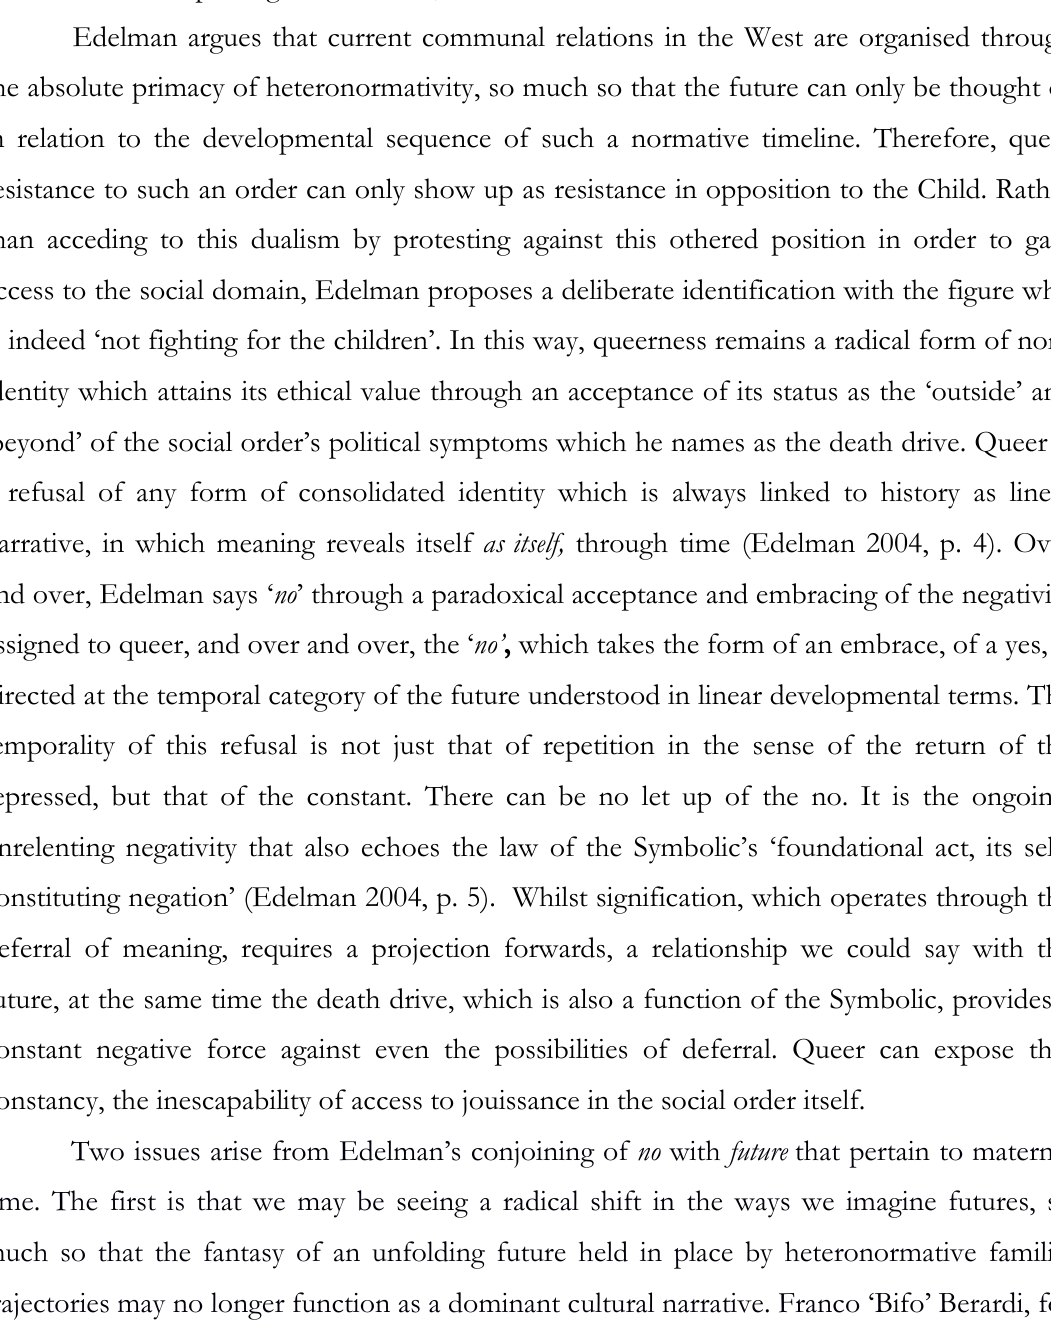
Lisa Baraitser, Time and Again: Repetition, Maternity and the Non-Reproductive Studies in the Maternal , 6(1), 2014,